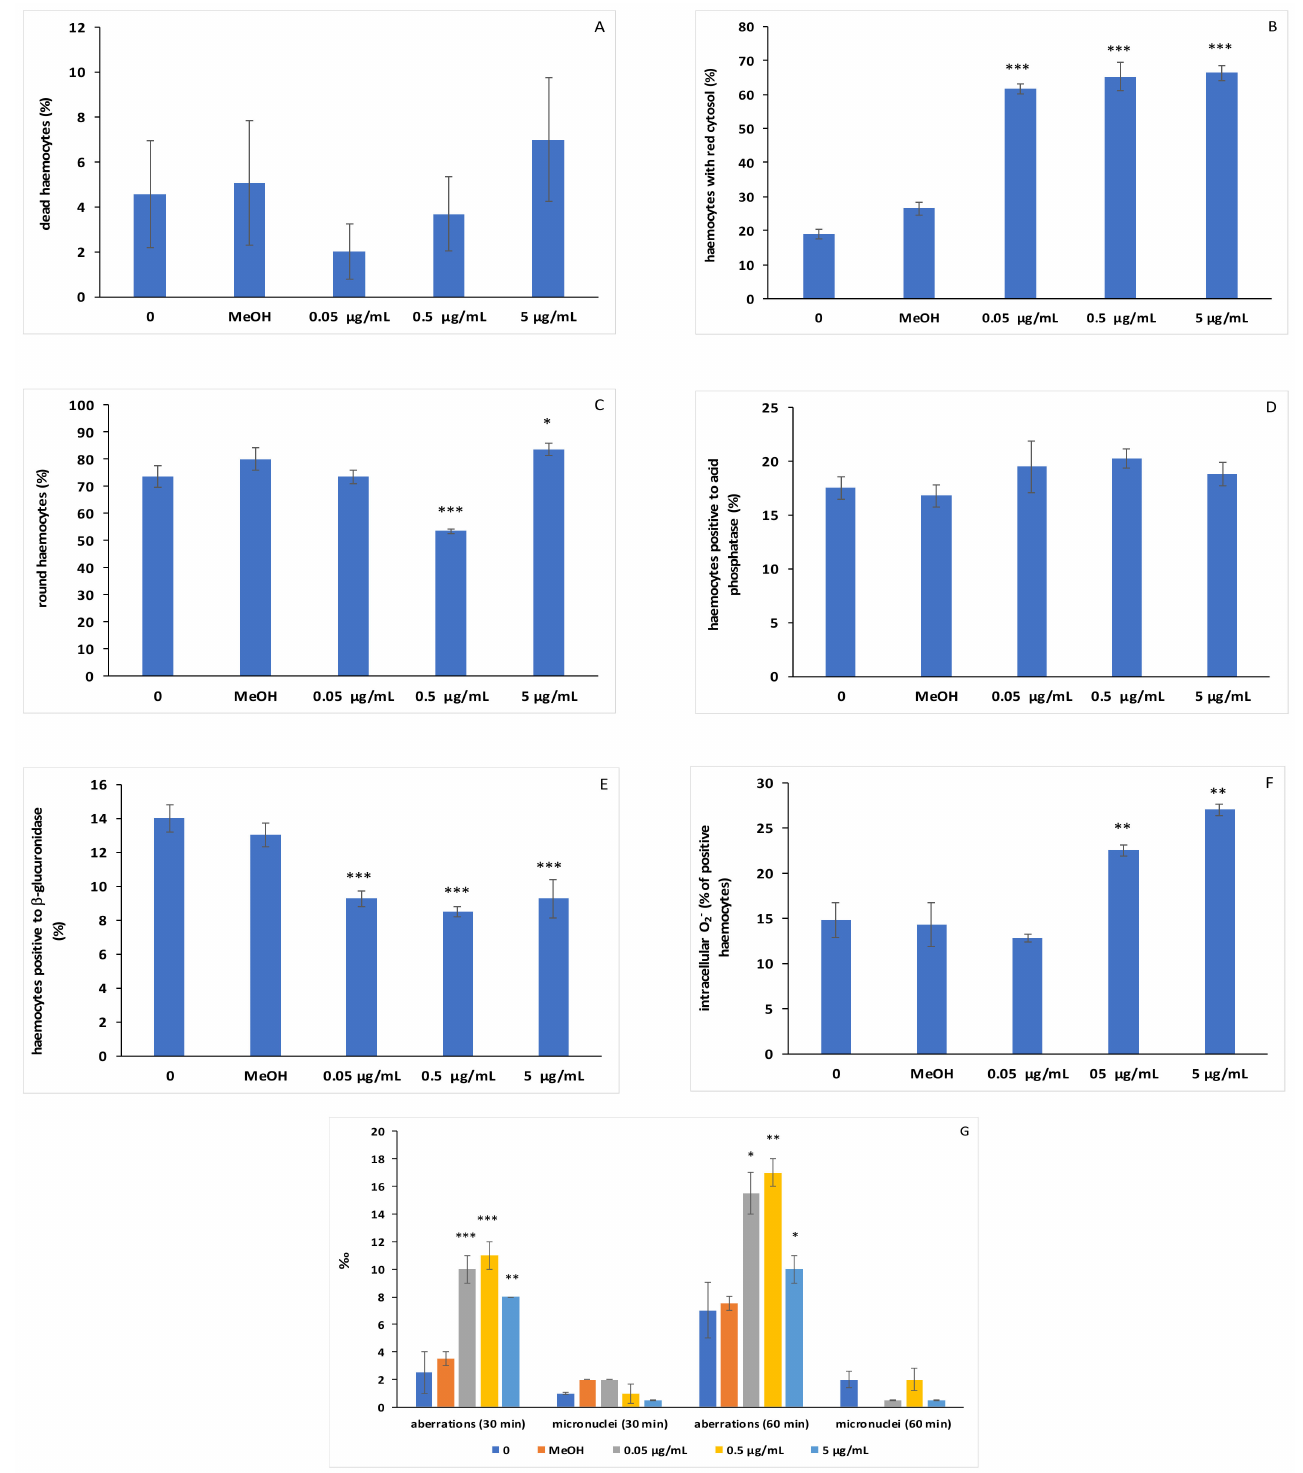
Figure 2. Haemocytes of R. philippinarum exposed to C6O4. ( A ) Percentage of dead haemocytes stained with Trypan Blue. ( B ) Percentage of haemocytes showing Neutral Red loss into the cytoplasm. ( C ) Percentage of round-shaped haemocytes stained with Giemsa. ( D ) Percentage of haemocytes positive to acid phosphate. ( E ) Percentage of haemocytes positive to β -glucuronidase. ( F ) Percentage of haemocytes with blue precipitated formazan, denoting O 2 - production. ( G ) Frequency of chromosomal aberrations and micronuclei after 30 and 60 min of exposure of haemocytes to C6O4. Values are means + SD, n = 3. Asterisks denote significant differences with respect to controls (0): * p < 0.05, ** p < 0.01, *** p <